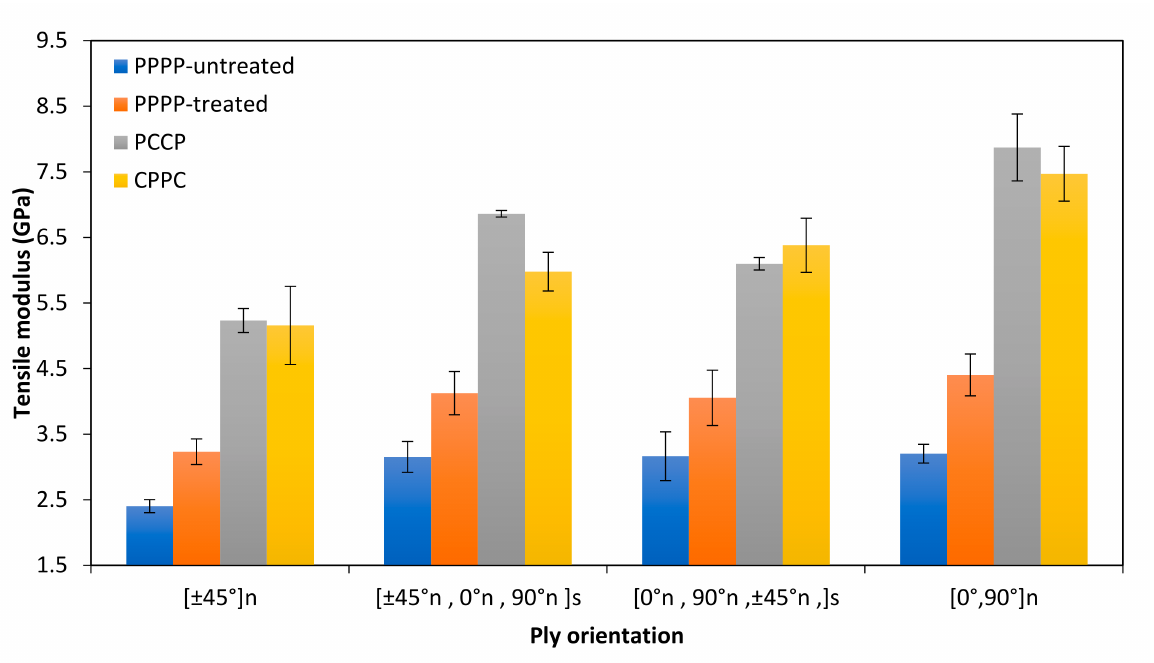
Figure 3. Tensile modulus of PALF/carbon hybrid laminate composites with different ply